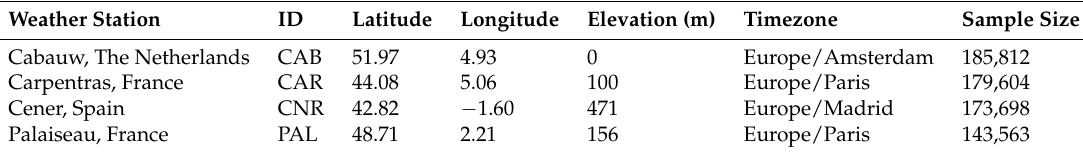
Table 4. BSRN weather stations in Europe and their